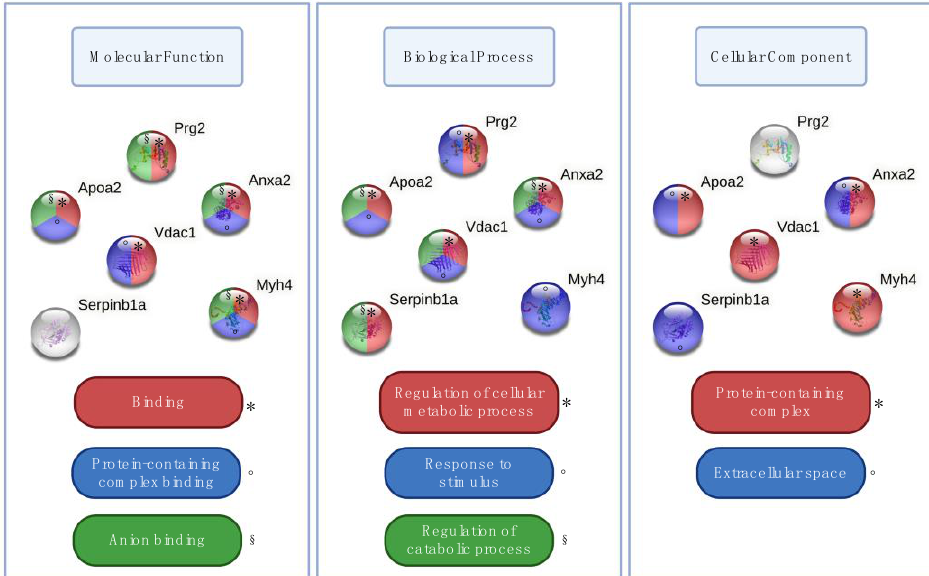
Figure 4. Functional enrichments in GO terms (molecular functions, biological processes, and cellular components) for the six proteins identified as being significant among the groups. For each GO class, different colours and symbols represent a specific GO term.